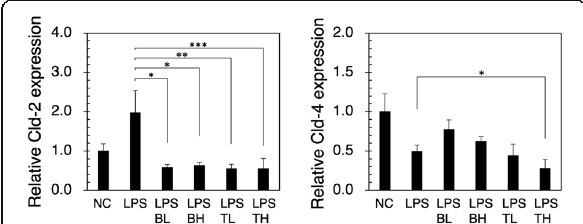
Fig. 4 Semi-quantification of Cld-4 and Cld-2 expression in ileum. Ileum was collected from D-mannitol group (n = 6). Cld-4 and Cld-2 expression were evaluated using 2 - ΔΔ Ct method. The mean Ct value of target genes in the experimental group was normalized to the Ct value of GAPDH to give a Δ Ct value, which was further normalized to NC group to obtain ΔΔ Ct. Bars represented the 2 - ΔΔ Ct and RQ min/max values. RQ values are derived using standard deviation. Differences between groups were considered significantly different when p * < 0.05, ** p < 0.01 and *** p < 0.001 relative to the LPS